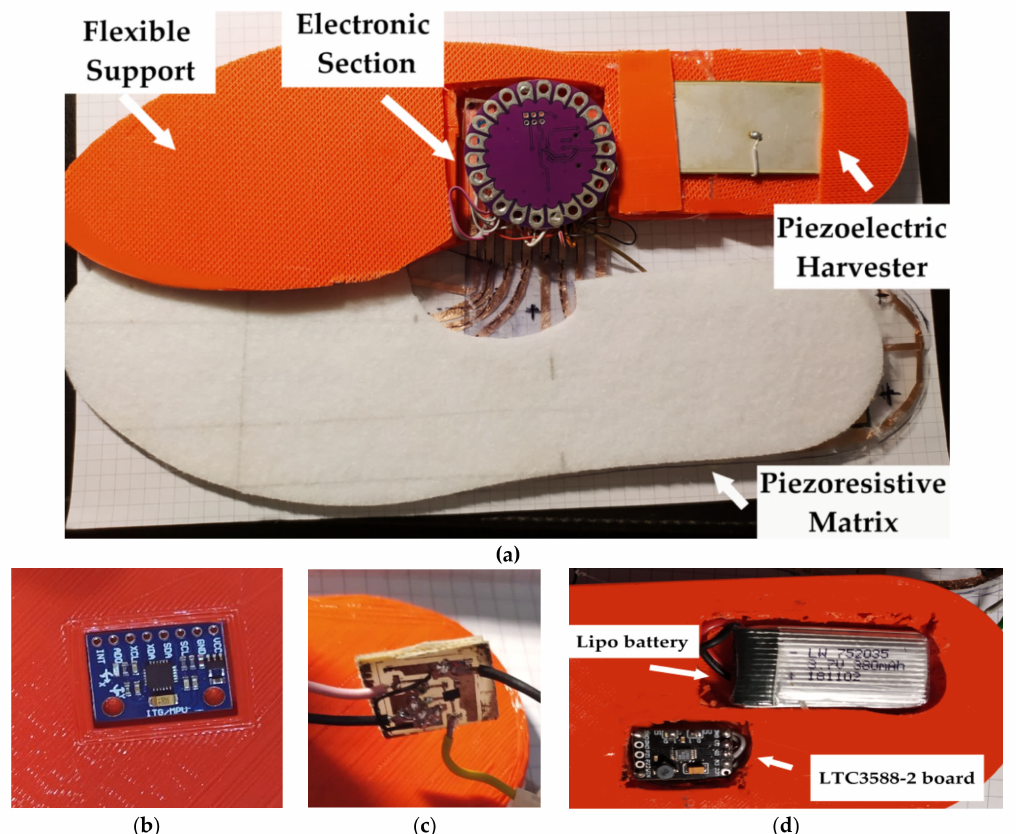
Figure 24. Image of the disassembled slab, which highlights the main sections ( a ) and detail of the housing where the three-axis accelerometer MMA8452Q is placed ( b ) and detail of the voltage regulator used to feed the insole ( c ); insole bottom where are integrated the 380-mAh Lipo battery and the harvesting section based on the LTC3888-2 board ( d